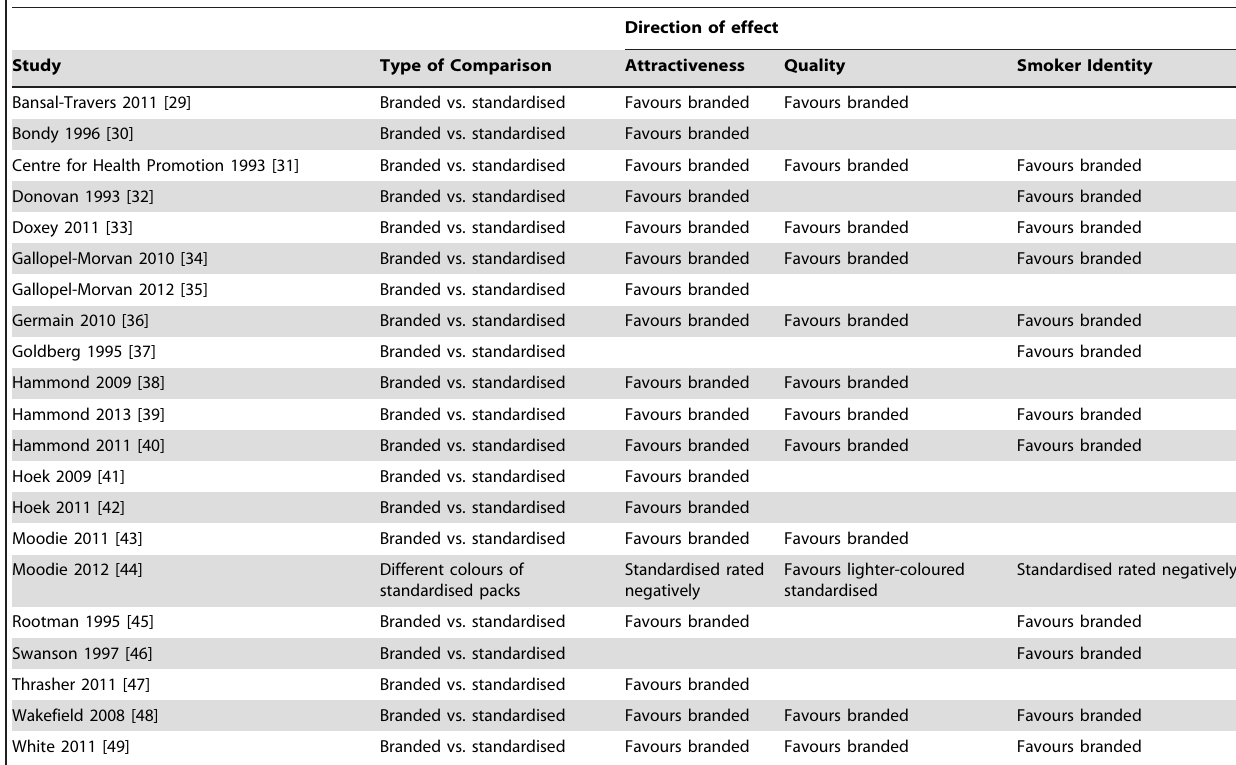
Table 1. Direction of effect: Attractiveness, quality and smoker